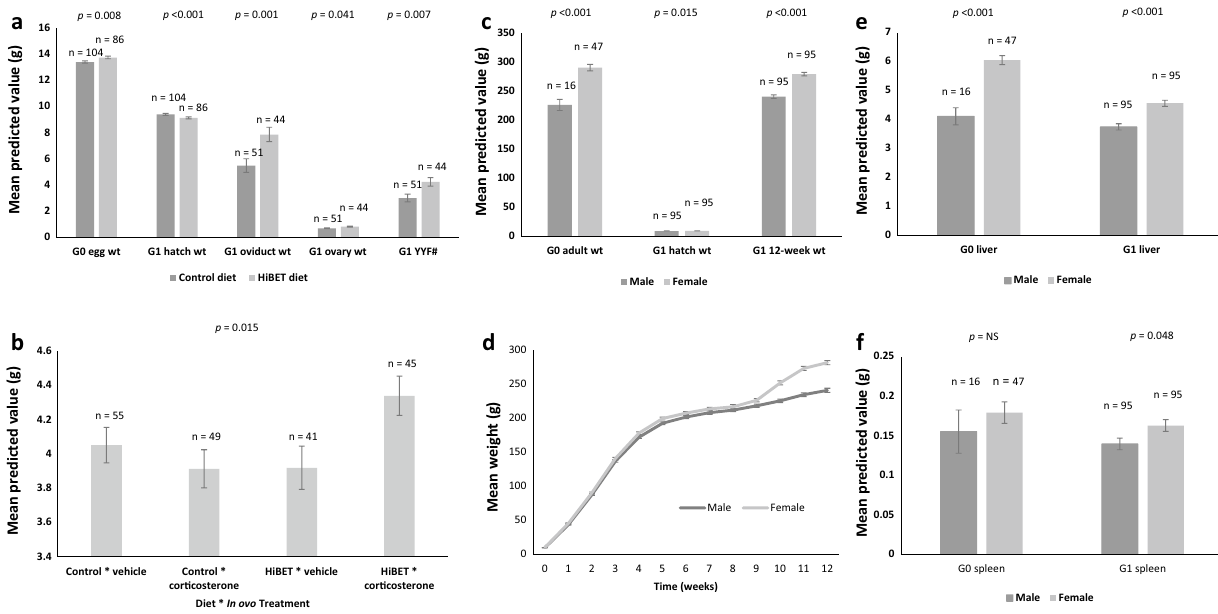
Figure 1. Growth and productivity of G 0 and G 1 quail. Significance ( p ) values are indicated for each trait. ( a ) Mean predicted value of parental diet effect on egg weight, G 1 chick hatch weight, G 1 oviduct weight, G 1 ovary weight (g; ± s.e.m.) and G 1 yellow yolked follicle number (YYF #; ± s.e.m.). HiBET = betaine enhanced diet. ( b ) Mean predicted value of diet by in ovo treatment interaction for G 1 liver weight (g; ± s.e.m.). ( c ) Mean predicted value of sex for G 0 body weight, G 1 hatch weight and G 1 12 week weight (g; ± s.e.m.), where Wt = weight. ( d ) Unadjusted mean G 1 body weight (g) ± s.e.m. from hatch to twelve weeks. ( e ) Mean predicted value of sex on G 0 and G 1 liver weight (g; ± s.e.m.). ( f ) Mean predicted values of sex on G 0 and G 1 liver, and G 1 spleen weight (g; ±